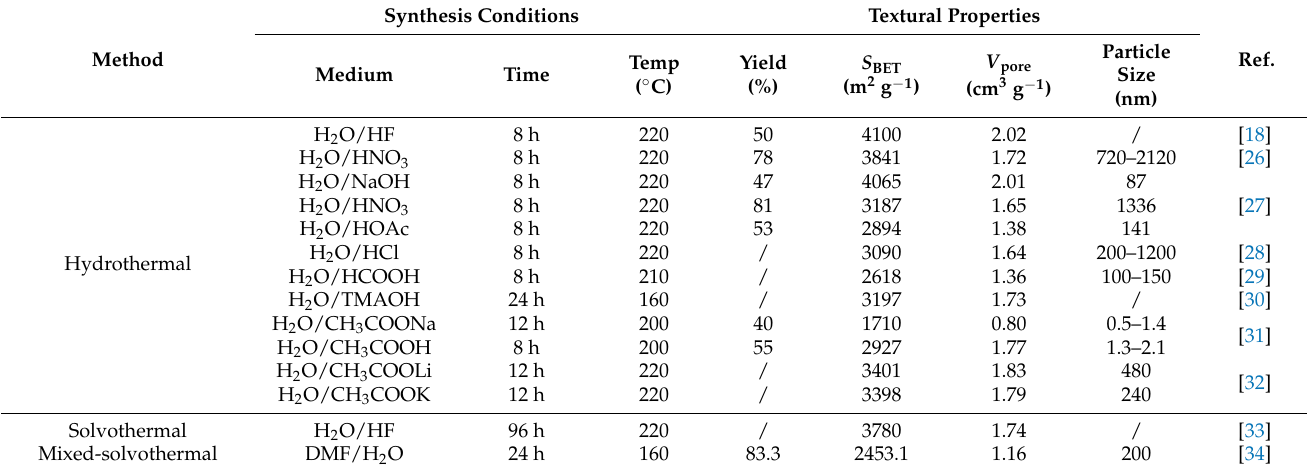
Table 1. Summary of studies on the synthesis of MIL-101(Cr) by different synthetic methods.